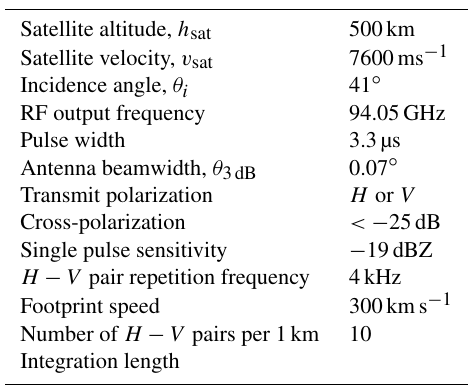
Table 1. Specifics of the radar for the simulation. The configuration adopted here is the one proposed for WIVERN in a recent ESA Earth Explorer 10